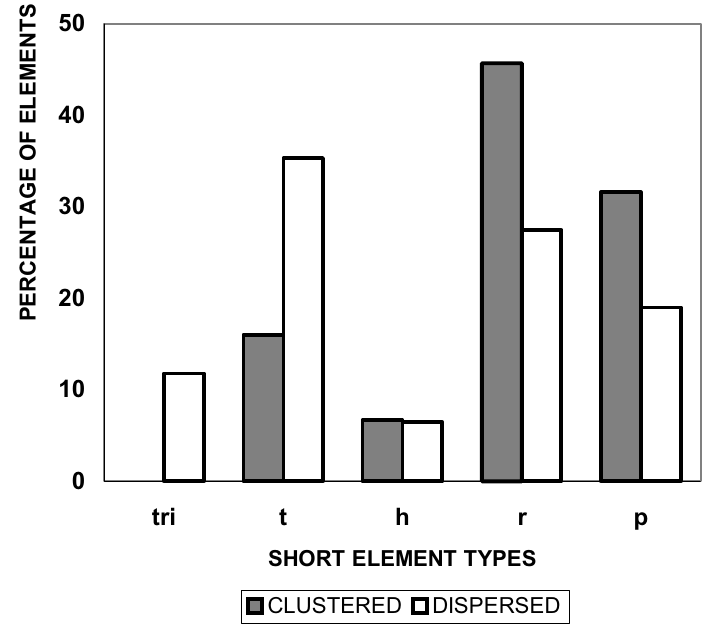
Fig. 4 – Percentage of short elements types (p, t, h, r, tri) recorded in two feeding contexts: muriquis feeding on the same tree (clustered), or in different trees